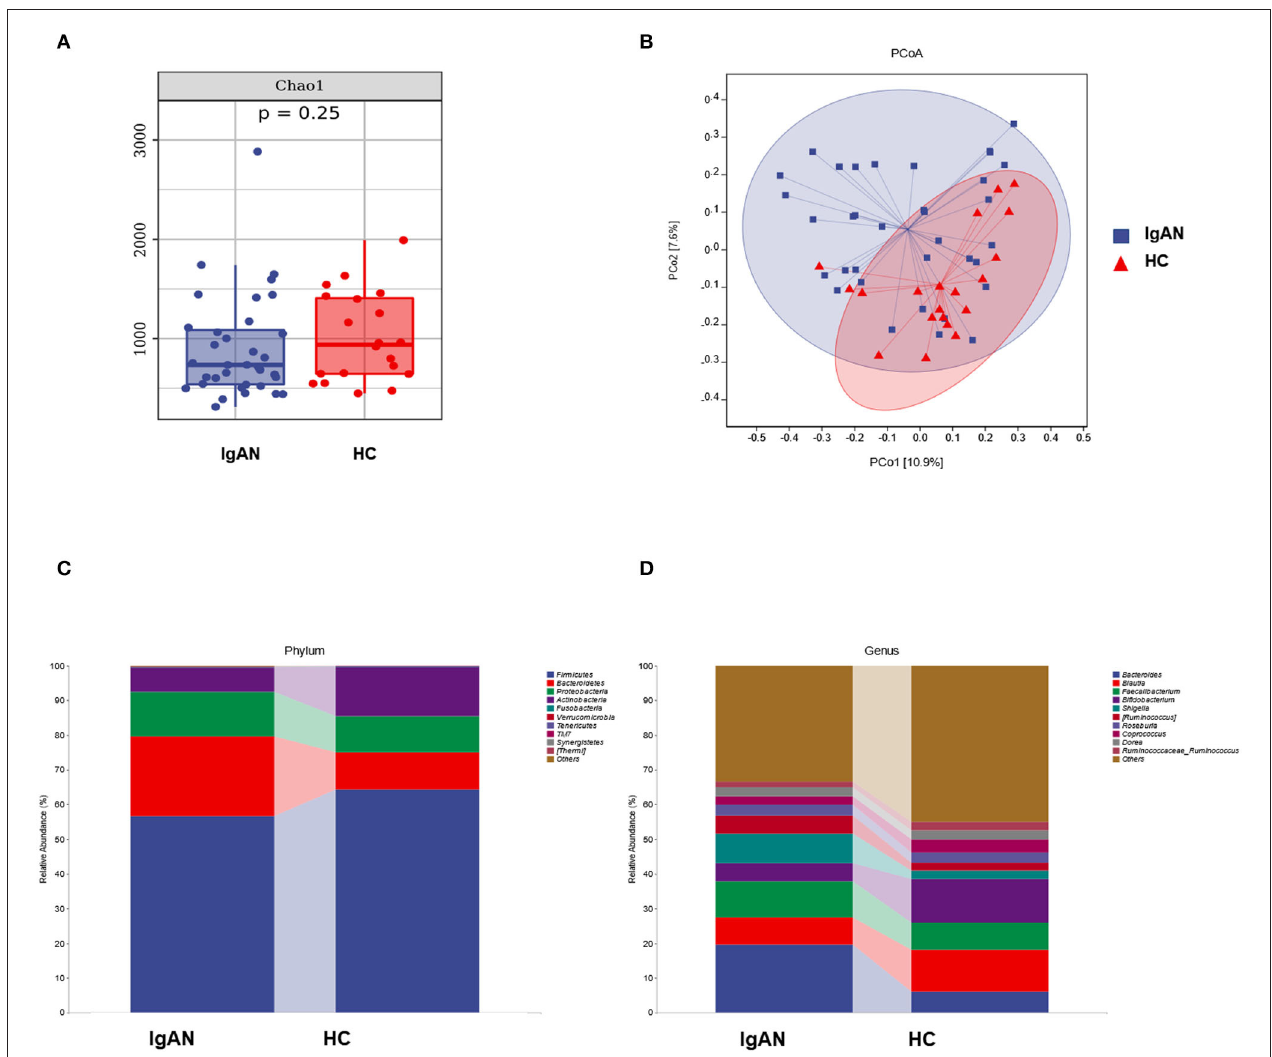
FIGURE 3 | The analysis of intestinal microbiota of the two groups. (A) The alpha diversity, (B) PCoA analysis, and (C,D) the microbiota structure of the two groups at the level of phylum and